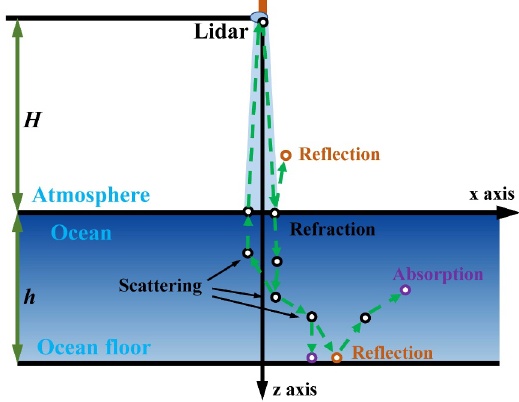
Figure 1. The schematic diagram of spaceborne lidar